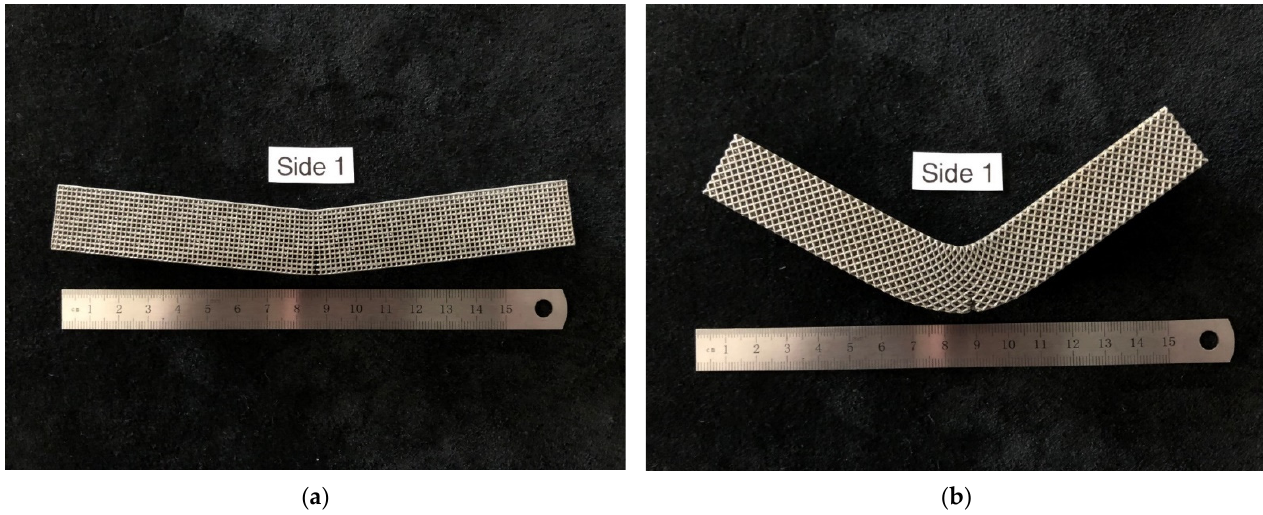
Figure 8. The 0.2% offset yield strength for diagonal scaffolds.